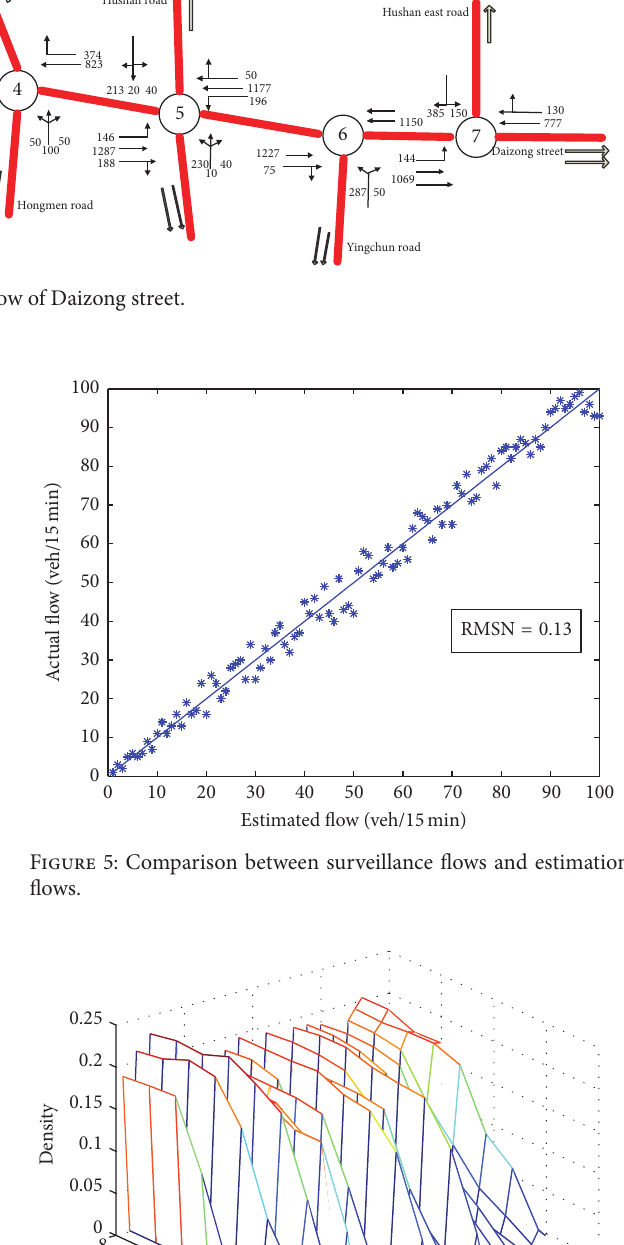
which existed on the fifth segment in the fifth interval. It was the most crowded at this time. The averaged density and sum density of the network in the whole simulation time were 0.0777 and 22.3873, respectively. Use the same method to analysis the averaged flow and speed. The total flow was 38915. The averaged flow of the network was 135.1215.